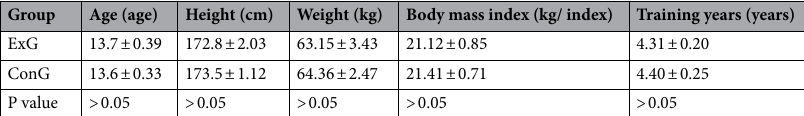
Table 1. Basic information of subjects. No significant difference P >